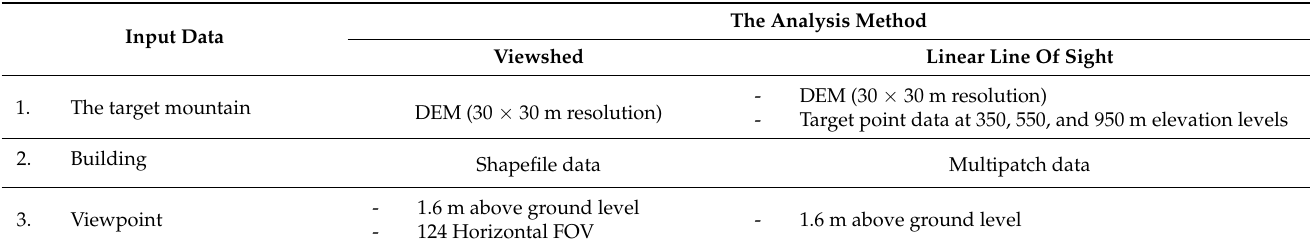
Table 3. The Input Data Types and Values for the Analysis